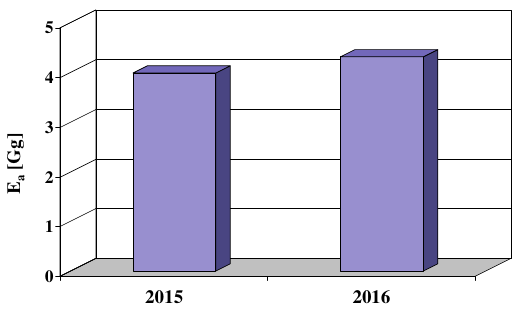
Fig. 10. National annual emission of particulate matter PM2.5 from motor vehicles in 2015 and 2016